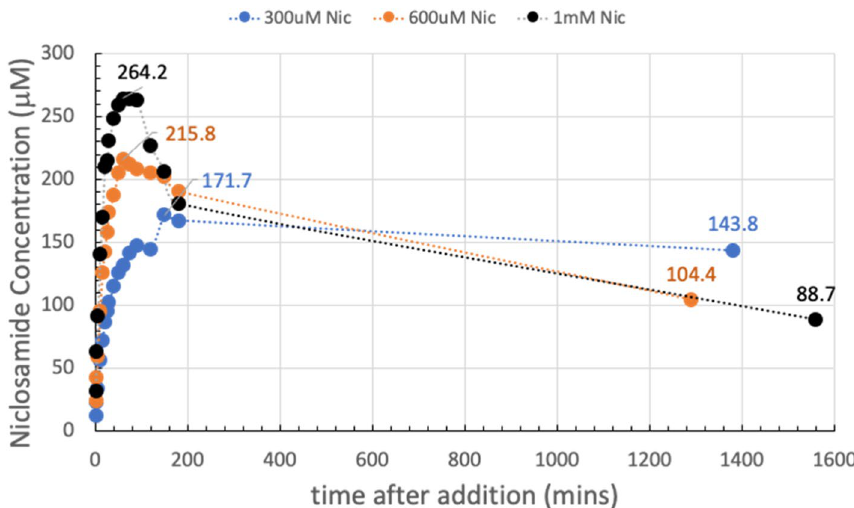
Fig. 6 Yomesan-niclosamide equivalent concentrations of 300 µM, 600 µM, and 1 mM in nominal 9.34 TB (0–day 2). Final pHs were ~ 9.2. Peak concentrations: 171.7 µM, 215.8 µM, and 264.2 µM; day 2 concentrations: 143.8 µM, 104.4 µM, and 88.7 µM respectively; average day 2 value µM 28.4 ±